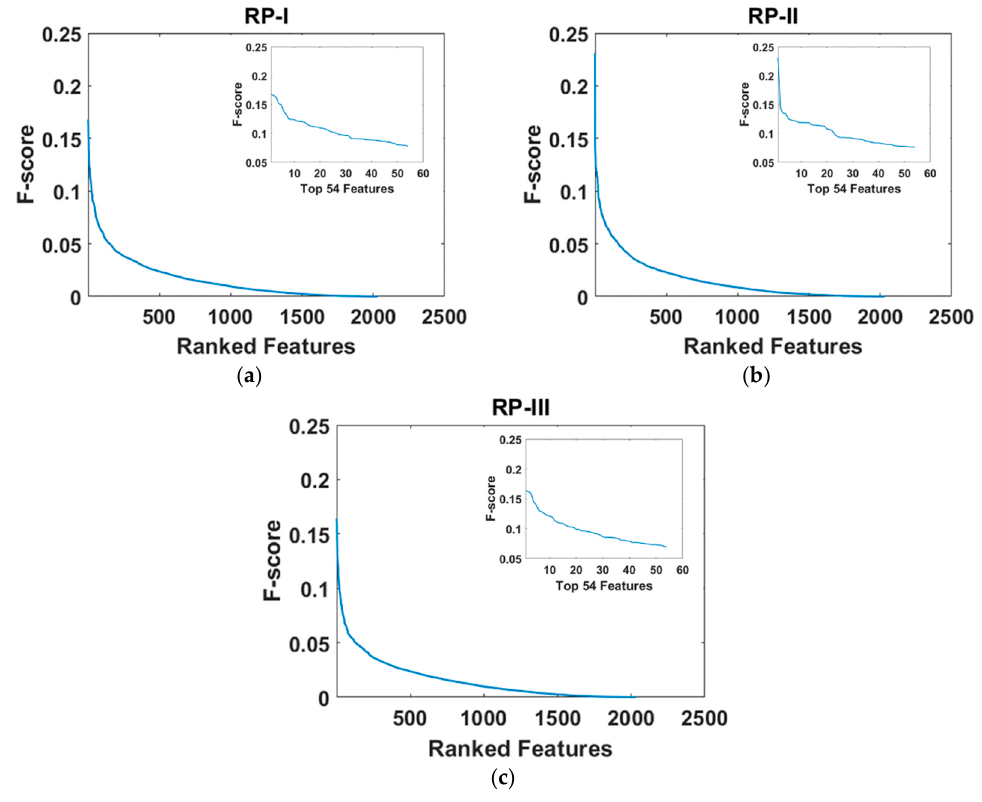
Figure 6. Fisher ratio (F-scores, sorted from high to low) of the 2030 ( a ) RP-I; ( b ) RP-II; and ( c ) RP-III features extracted during the emotion-induction state. The F-scores of the top 1 RP-I, RP-II, and PR-III features are 0.1680, 0.2311, and 0.1643, respectively. The F-score curves for the three types of relative power features decrease rapidly. The 54th features’ F-scores are 0.0779 (RP-I), 0.0762 (RP-II), and 0.0695 (RP-III), respectively. Finally, the F-score curves converge to near-zero, showing that most of the 2030 relative power features are noisy.